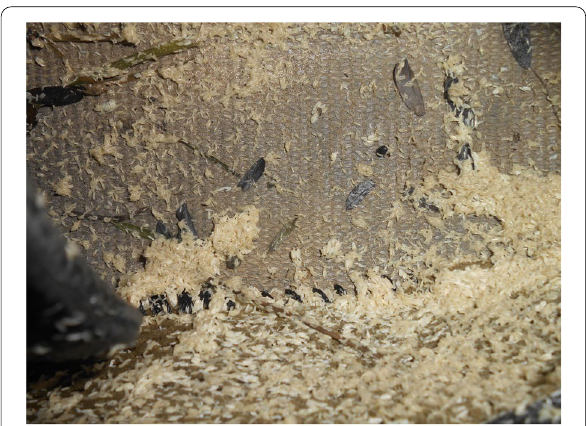
Fig. 1 Eggs and larvae of Ch. megacephala on the clothes of the deceased in case 1